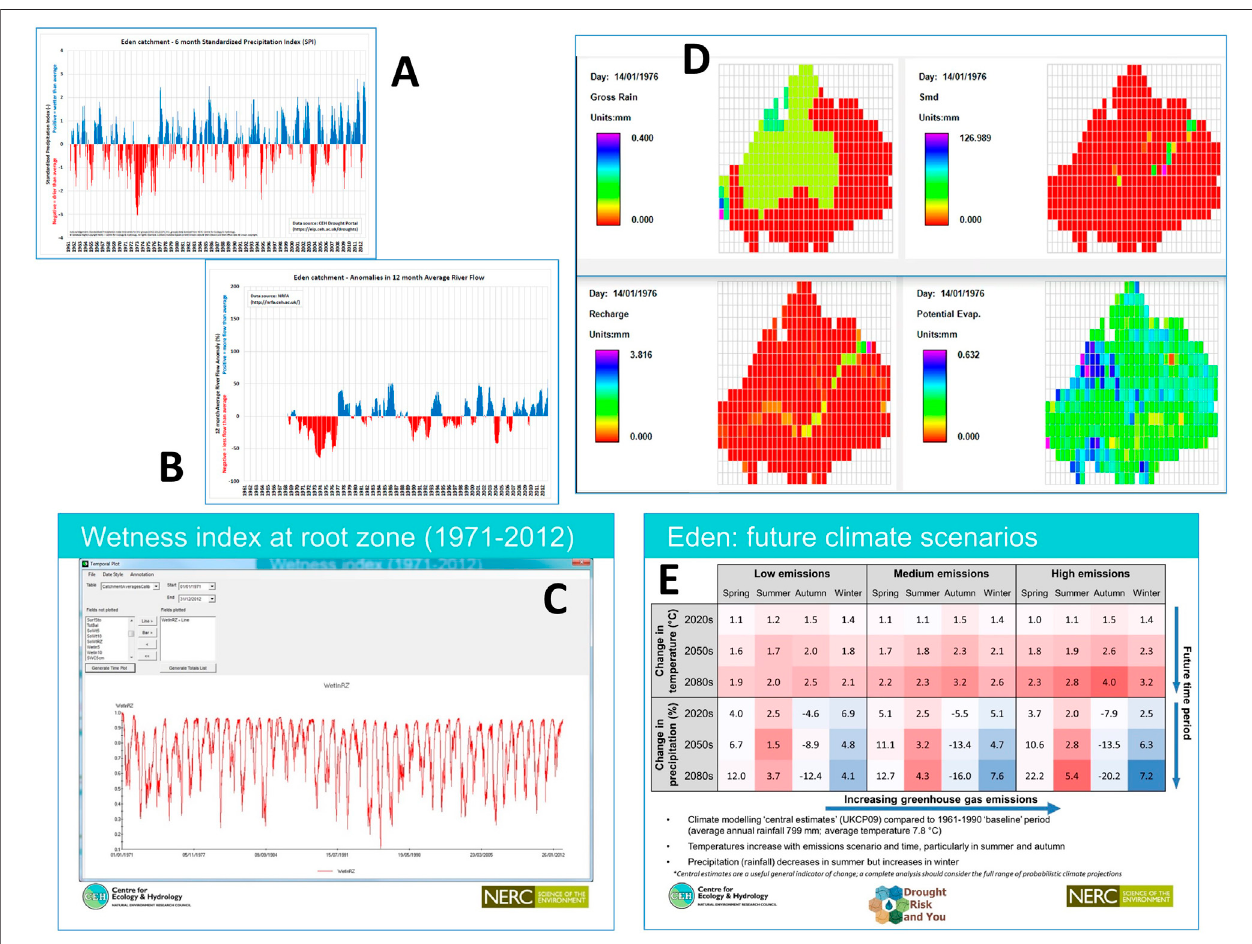
FIGURE 2 | Indicative composite of the scienti fi c graphs and fi gures used in the various stakeholder engagement activities within the Eden catchment (for other examples, see Afzaland Ragab, 2020). (A) Time-series rainfall anomaly plot (SPI; 6 months); (B) Time-series — average river fl ow anomaly plot (C) Wetness index times- series generated by DiCaSM (D) Animation of drought indices through 1976 as front end to DiCaSM; (E) Example distillation of bite-sized science – UKCP09 scenarios.